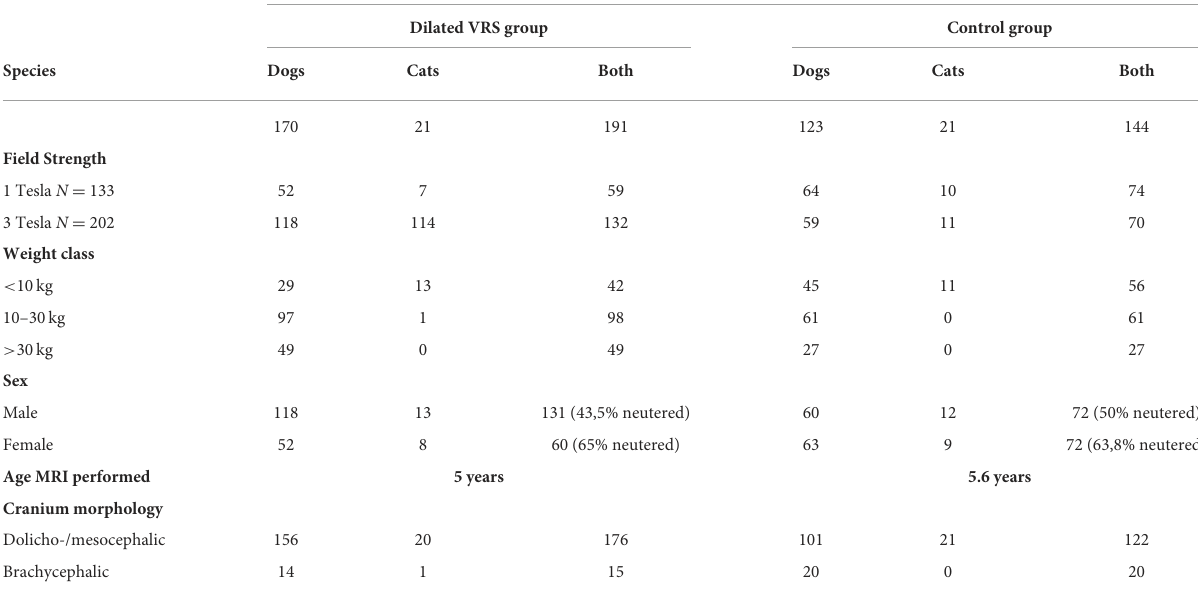
TABLE 1 Demonstrating the distribution of patient criteria subdivided into both study groups (dilated VRS and control group). 335 patients (293 dogs, 42 cats) Dilated VRS